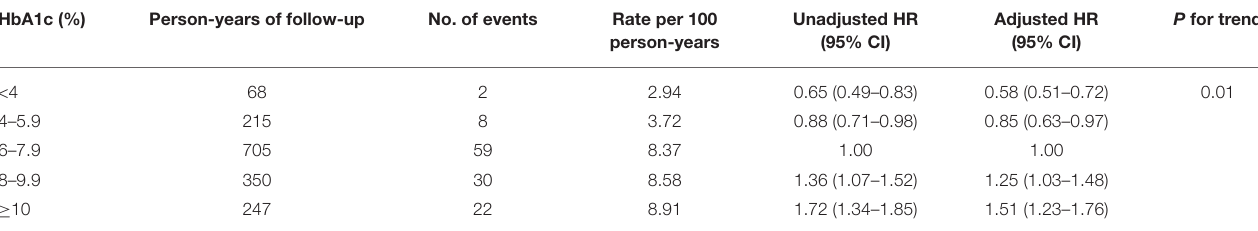
TABLE 1 | Hazard ratios of atrial fibrillation recurrence after ablation by 5 levels of HbA1c as continuous variables. HbA1c